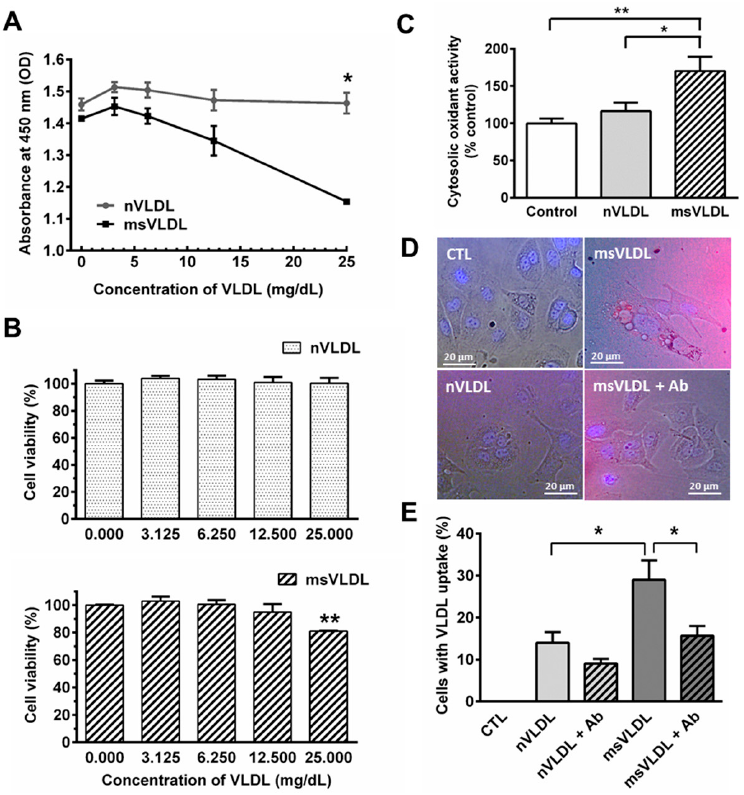
Figure 1. Metabolic syndrome-very low density lipoproteins (MetS-VLDL) is cytotoxic and provokes oxidative stress, with greater internalization in HL-1 atrial myocytes. ( A ) HL-1 cells were treated with normal-VLDL or MetS-VLDL at different test concentrations (3.125, 6.25, 12.5 and 25 mg/dL) for 24 h. OD values at 450 nm indicating viability were significantly lower in the msVLDL group (* p < 0.05; n = 4 for each group); ( B ) HL-1 cells treated with MetS-VLDL showed significantly reduced cell viability (% of control) with a concentration of 25 mg/mL (** p < 0.01; n = 4); ( C ) DCF fluorescence (excitation at 480 nm and emission at 520 nm) indicated total cytosolic oxidant activity (values of % control; n = 3 for each group). MetS-VLDL significantly increased oxidative stress at 25 mg/dL (* p < 0.05; ** p < 0.01); ( D ) Representative images for control, nVLDL, msVLDL, and msVLDL with VLDL receptor (VLDLR) antibody (msVLDL + Ab) groups ( n = 3 for each group); ( E ) Internalization of DiI-labeled VLDL particles (red) increased in size and number in MetS-VLDL treated HL-1 cells (msVLDL) compared to normal-VLDL treated cells (nVLDL) (* p < 0.05, n = 3). Pre-treatment with VLDLR Ab for 24 h reduced internalization (* p < 0.05).